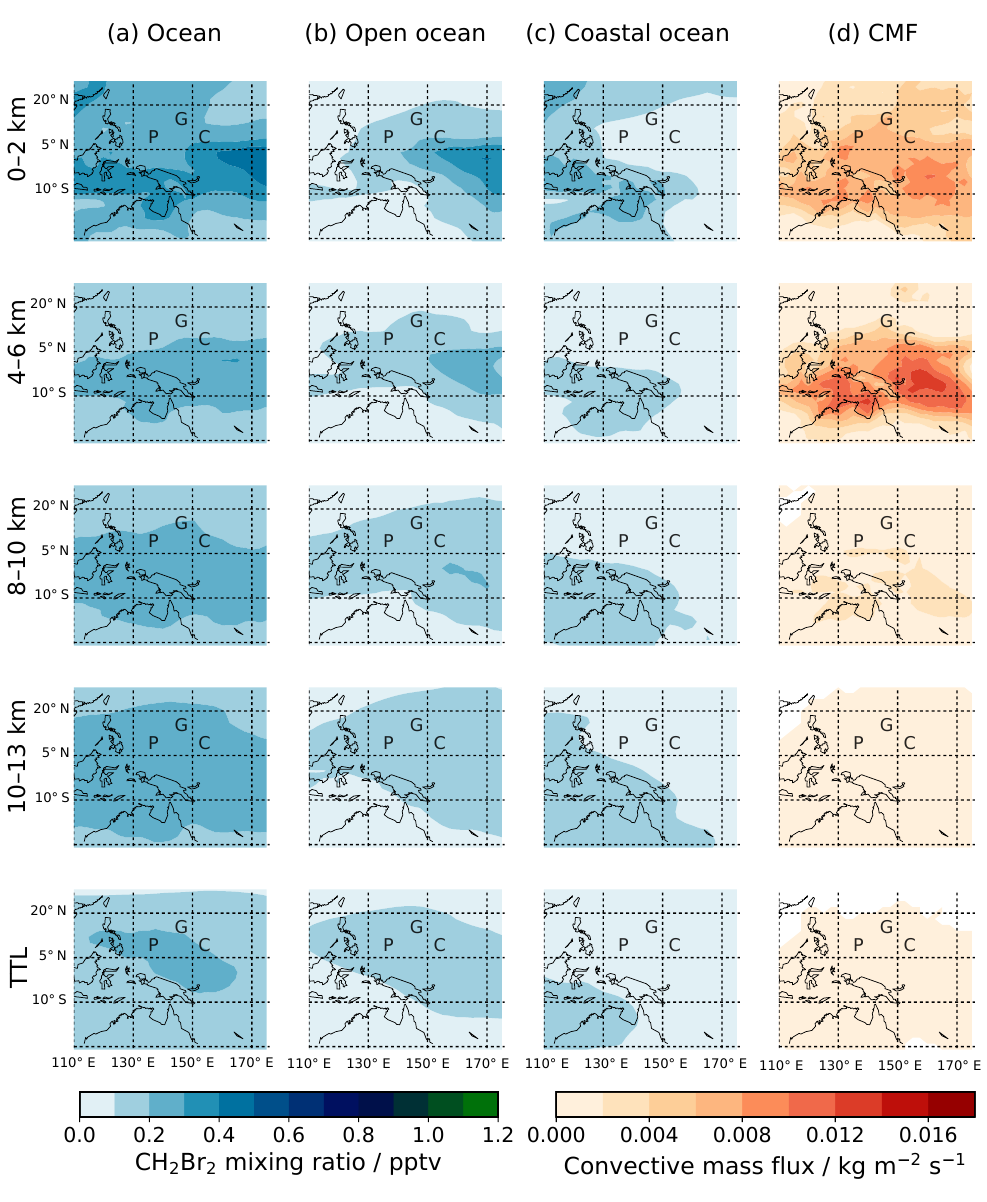
Figure 6. As Fig. 5 but for CH 2 Br 2 (pptv).